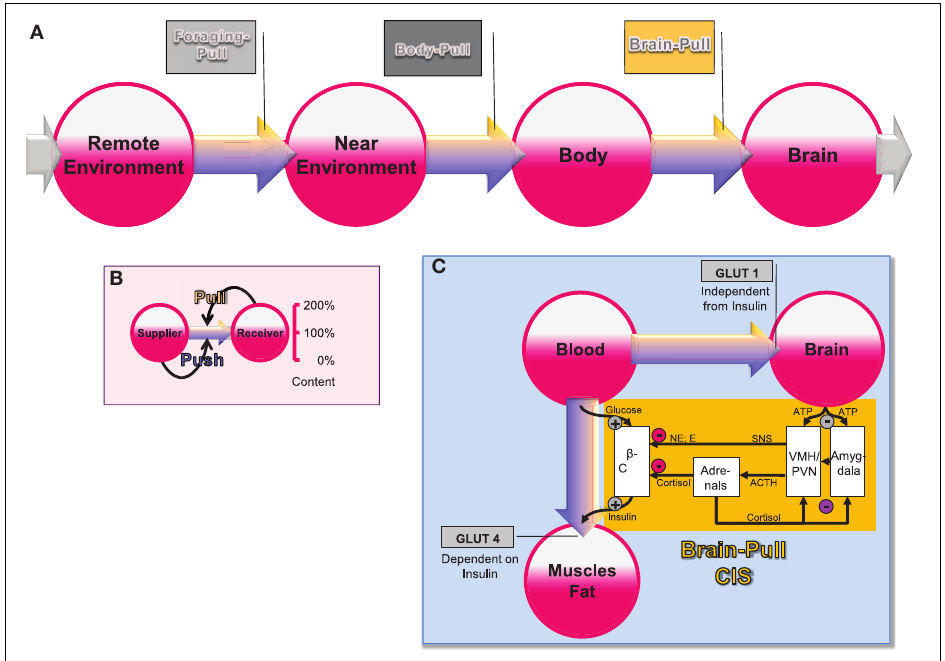
FIGURE 1 | General supply chain of the human brain. (A) Overview: energy from the remote environment is brought to the immediate environment, the body then takes it up, and from there a large part of it enters the brain. (B) The push-pull principle: in a general supply chain, the flux of energy can principally be determined by the supplier (previous step) or by the receiver (proximate step). The share of the flux, which is determined by the supplier, is called the “push component” (blue arrows), the share, which is determined by the receiver, is called the “pull component” (yellow arrows). (C) Conceptual diagram that shows key physiological mechanisms, which fulfill the brain-pull function of cerebral insulin suppression (CIS): the flux of glucose is either directed to the brain or to muscle and fat. If neuronal ATP concentrations fall, activation of neurons in the amygdala, in the ventromedial hypothalamus (VMH), and in the paraventricular nucleus (PVN) occurs, which in turn activates the sympathetic nervous system and the hypothalamus pituitary adrenal system (SNS and HPA). Both the SNS and the HPA system suppress insulin release from pancreatic beta cells, thereby decreasing glucose transporter 4 (GLUT-4) mediated glucose uptake into muscle and fat. In this way the brain limits glucose uptake in peripheral tissues and favors glucose transporter 1 (GLUT-1) mediated glucose uptake into the brain. Finally, the CIS-brain-pull system is hierarchically organized and adaptive. The central glucocorticoid feedback plays a critical role in determining whether the CIS-brain-pull system reacts in a high or low reactive manner. ACTH, Adrenocorticotropic hormone; E, epinephrine; NE,